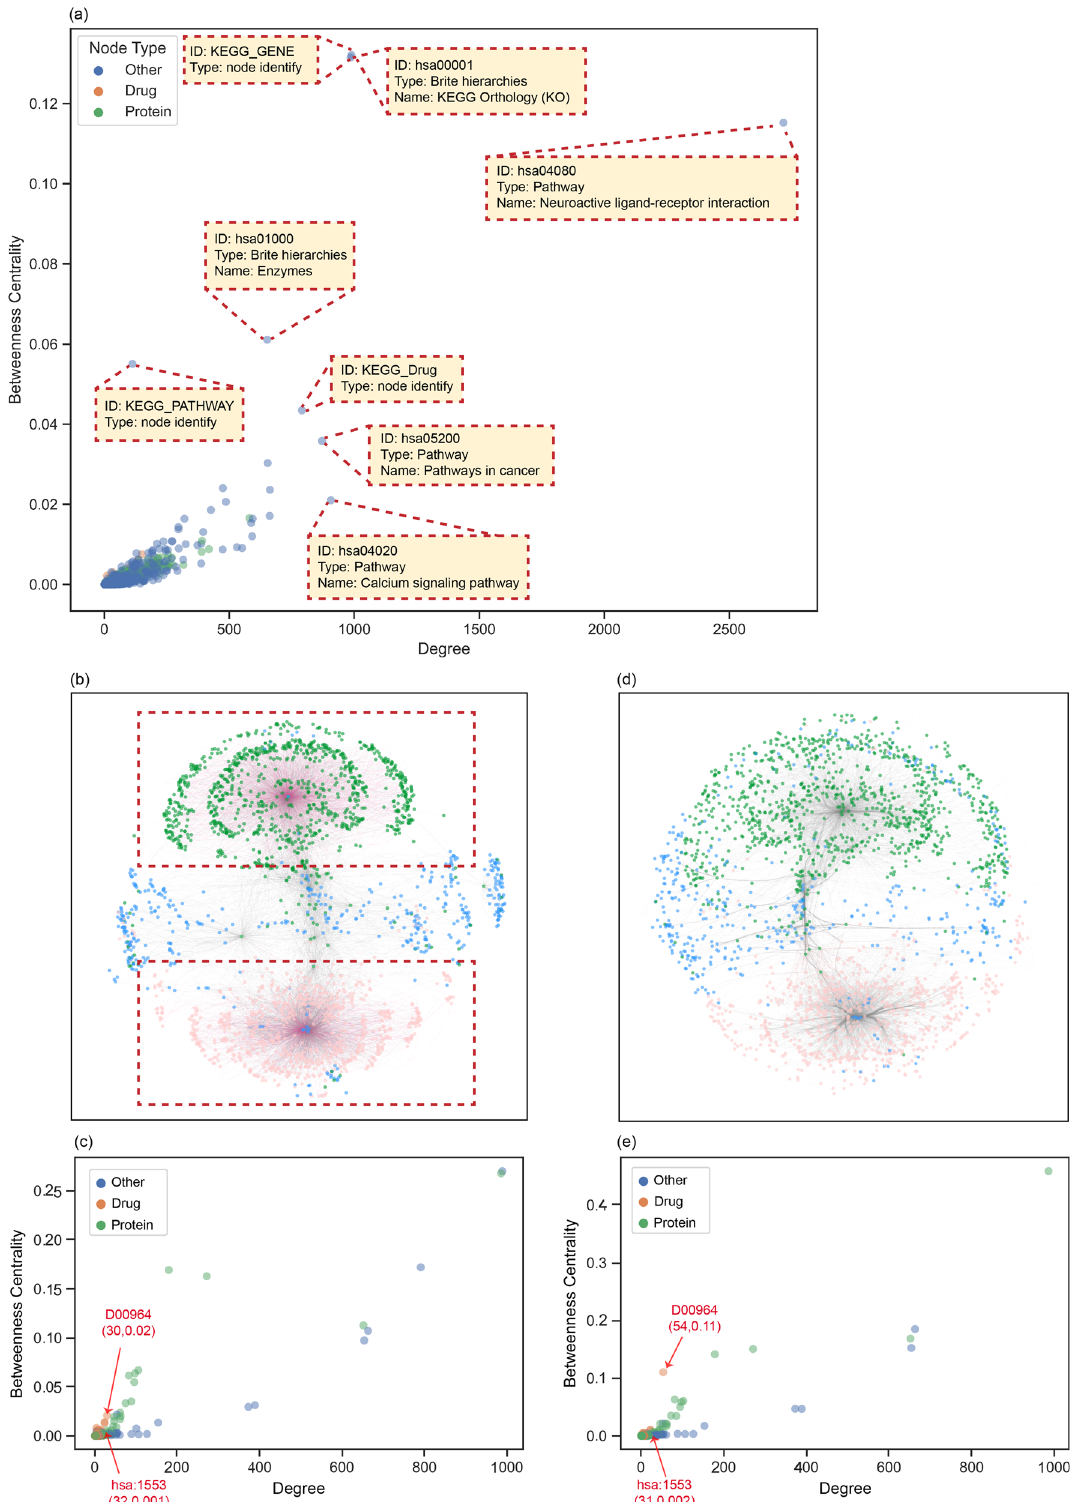
performance. In addition, KGE_NFM is a highly scalable fra- mework and enables the prediction more robust by integrating multi-modal data (i.e., structural information of biomolecules and association information from biochemical networks). Overall, KGE_NFM is a highly competitive approach for DTI prediction